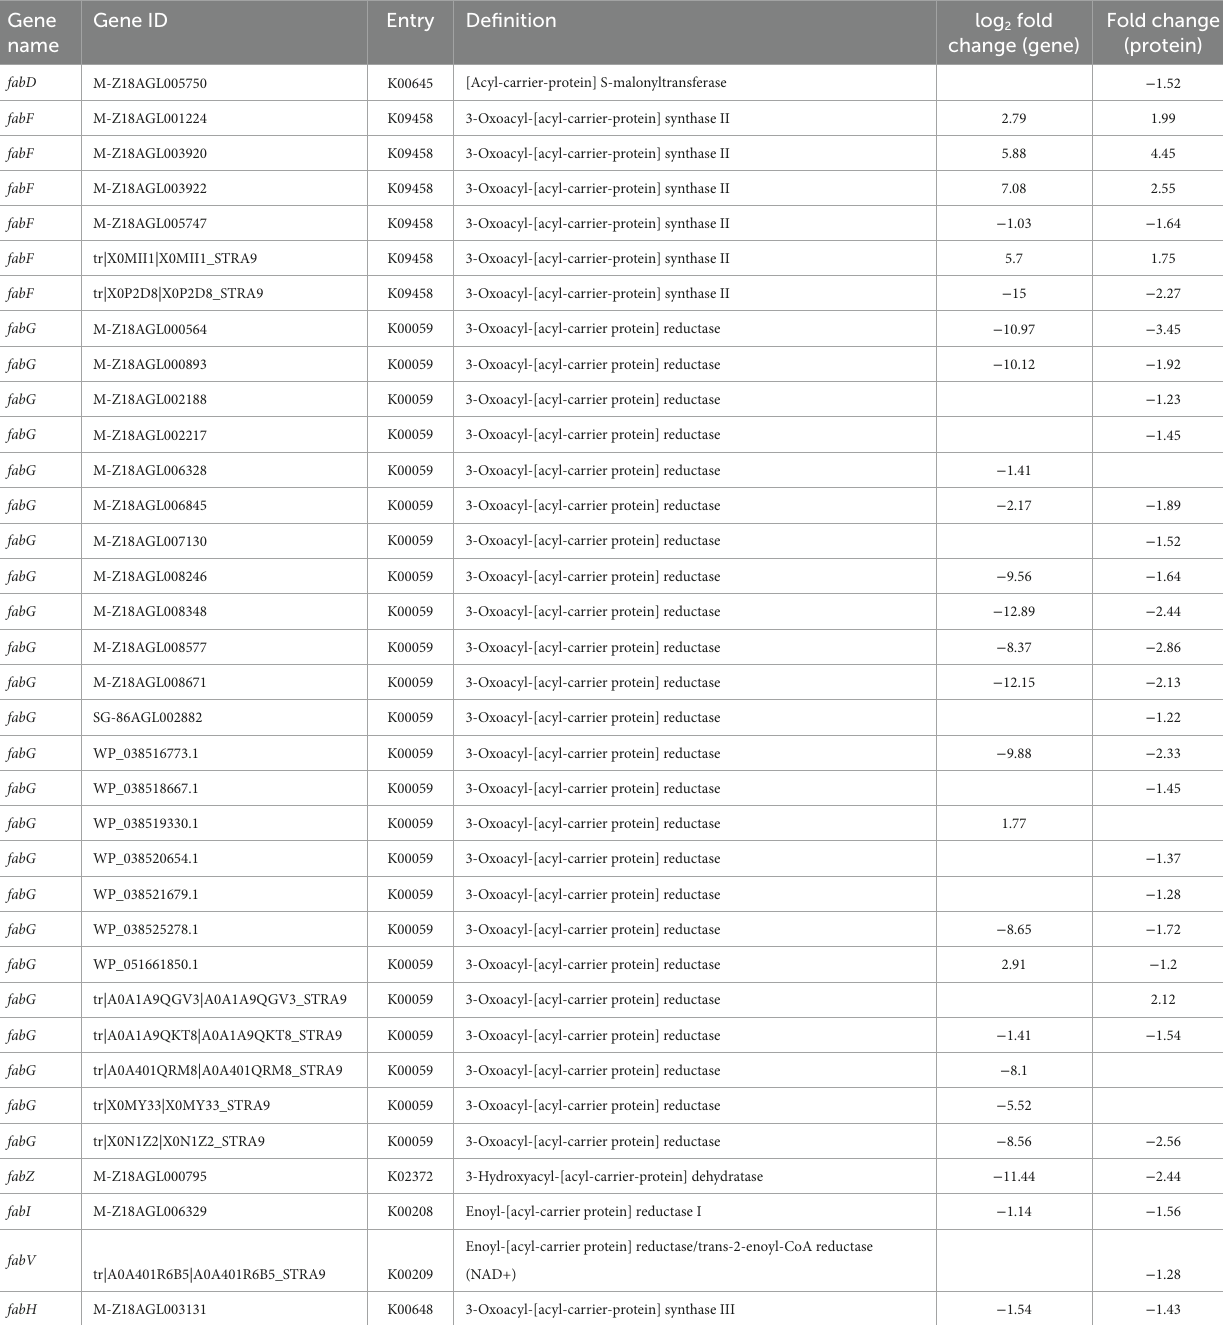
TABLE 4 Differential expression genes and proteins related to fatty acid biosynthesis between WG-608 and M-Z18. Gene